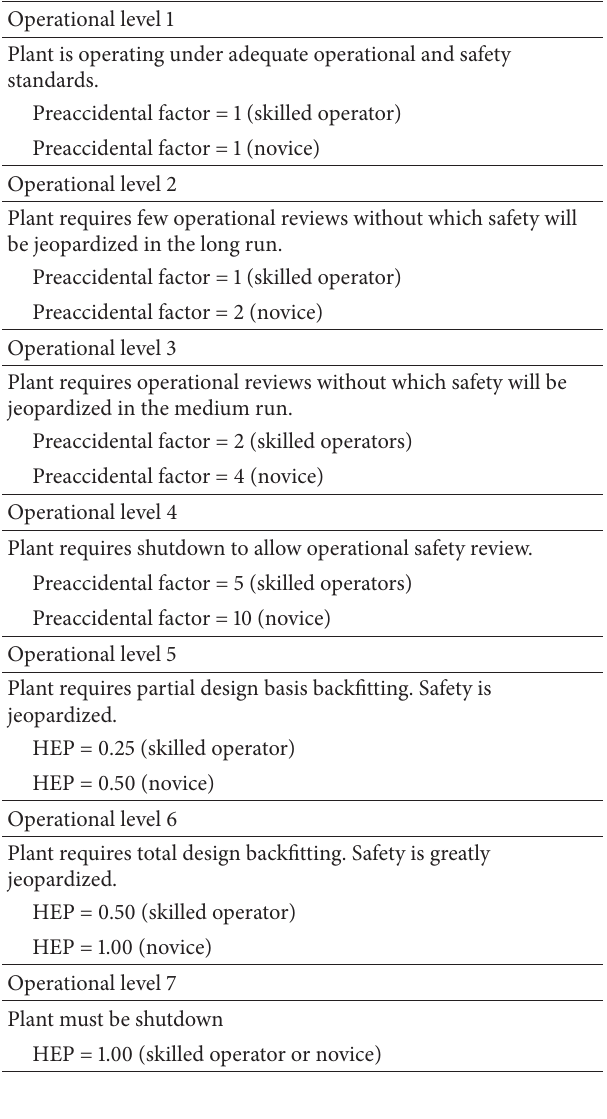
Table 1: Operational levels based on pre-accidental factors. Operational level 1